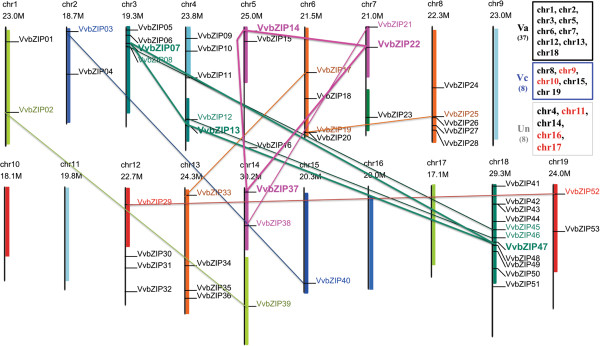
Distributions of VvbZIP genes in grapevine Chromosomes. Fifty-three VvbZIP genes were mapped to the 14 linkage groups. VvbZIP54 was located on 18 random chromosomes and VvbZIP55 was assigned to the Un chromosome. Five chromosomes (chr9, 10, 11, 16 and 17) have no grapevine bZIP gene, The schematic representation of paralogous regions was adapted from Jaillon et al., with the same color [35]. Acording to the former hypothesis [36], the ancestral hexaploid genome of V. vinifera was derived from an allopolyploidization of two ancestral genomes: Va and Vc, which are denoted on the right of the figure, and Un is unassigned chromosomes. The chr names in red underline the chromosomes that harbored no bZIP genes. The gene names with collinearity were performed with the some color of chromosome paralogous region.